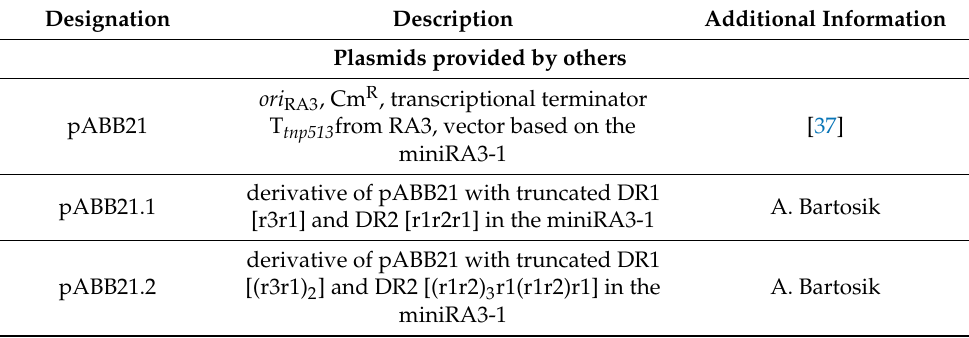
Table 2. Plasmids used in this